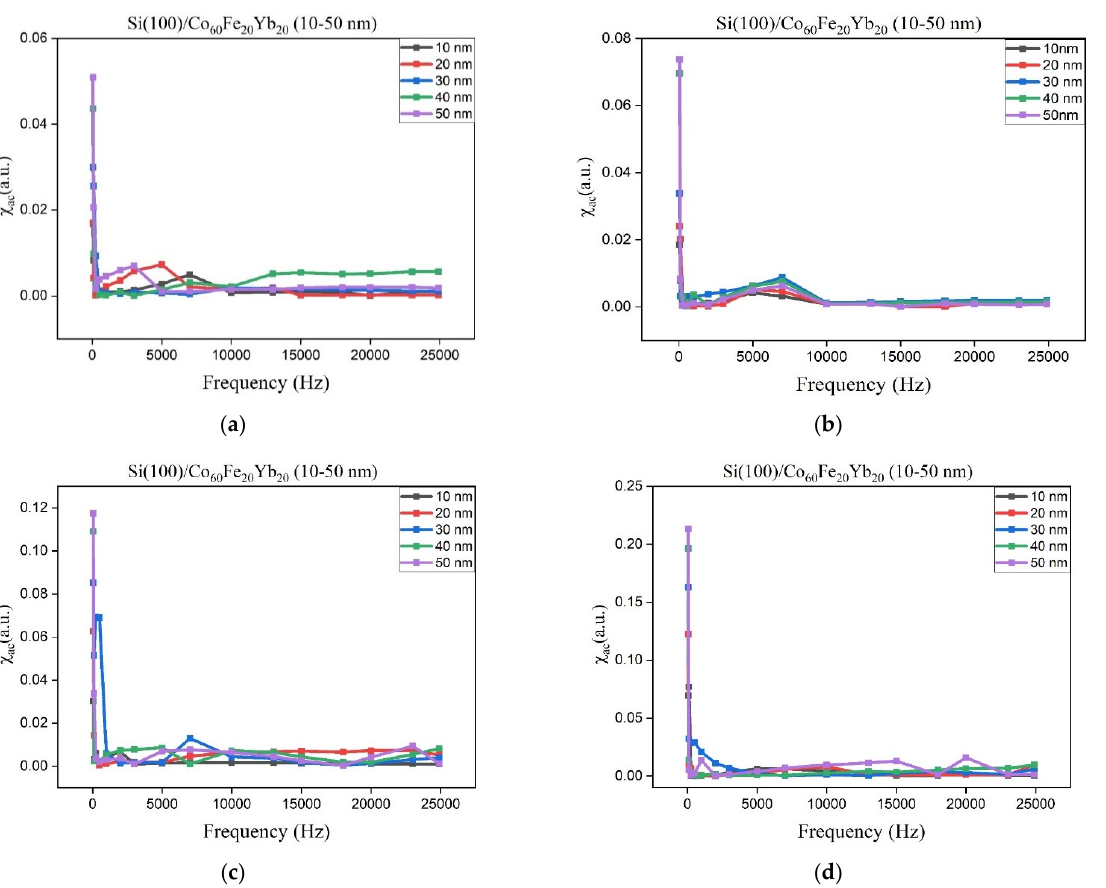
Figure 2. χ ac as a function of frequency from 50 to 25,000 Hz. ( a ) RT, ( b ) after annealing at 100 °C, ( c ) after annealing at 200 °C, ( d ) after annealing at 300 °C.